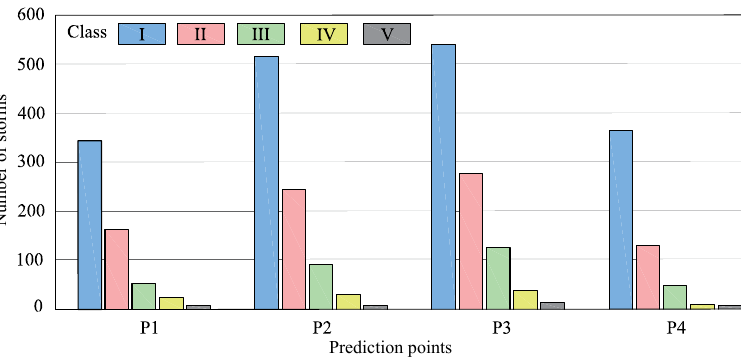
Figure 5. Distribution of storm events per class at each